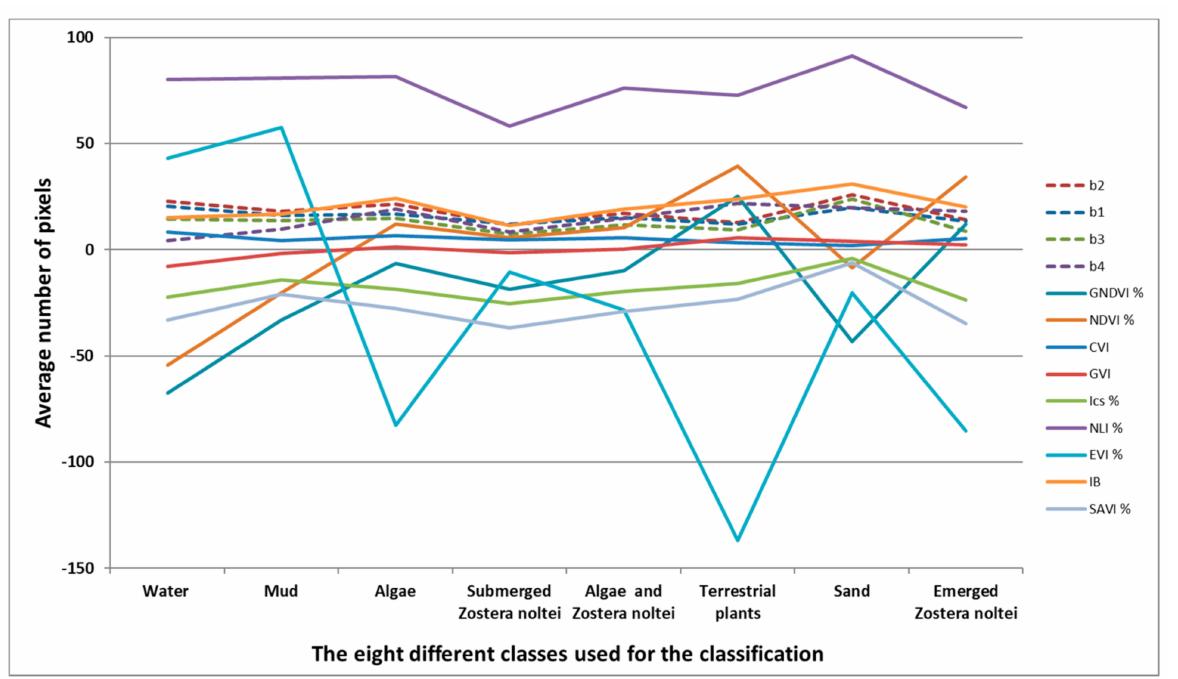
Figure 6. The average of 1371 pixels per class for each of the 4 Bands and 9 indices of the SPOT 7 image.